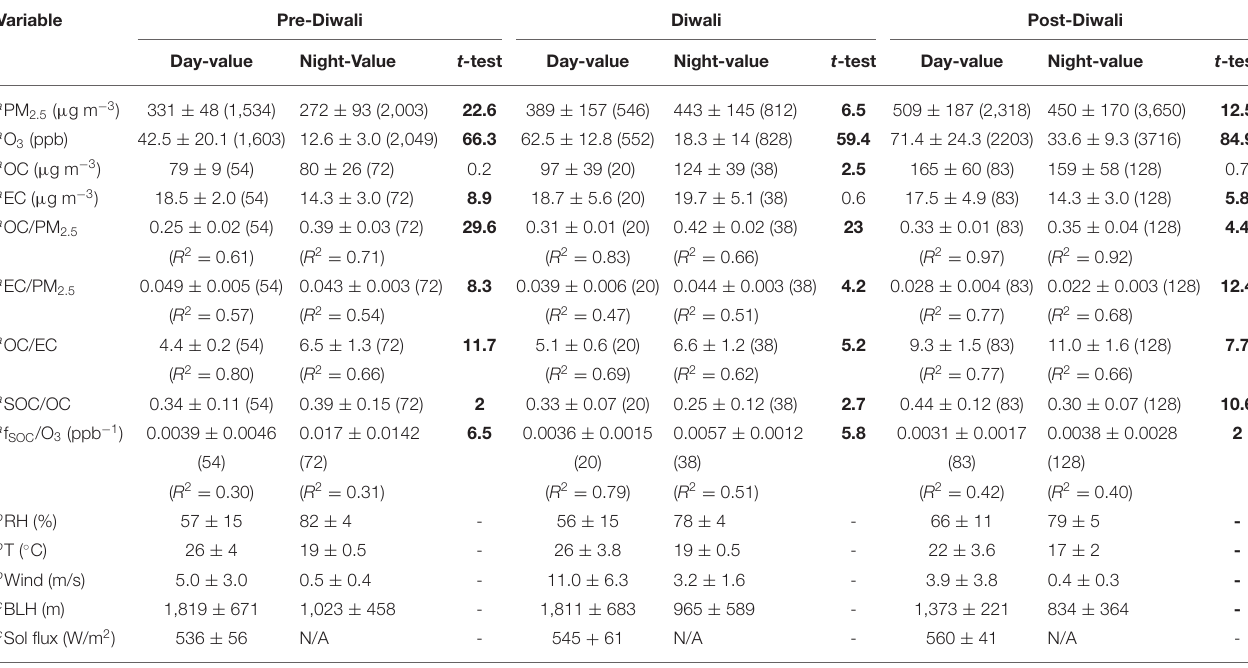
TABLE 1 | Summary statistics of data set [Avg. ± SD ( number of samples )] during the sampling period (08th Nov − 16th Nov 2015; where 08–10th Nov is considered as Pre-Diwali period, 11th Nov as Diwali, and 12–16th Nov as Post-Diwali period).